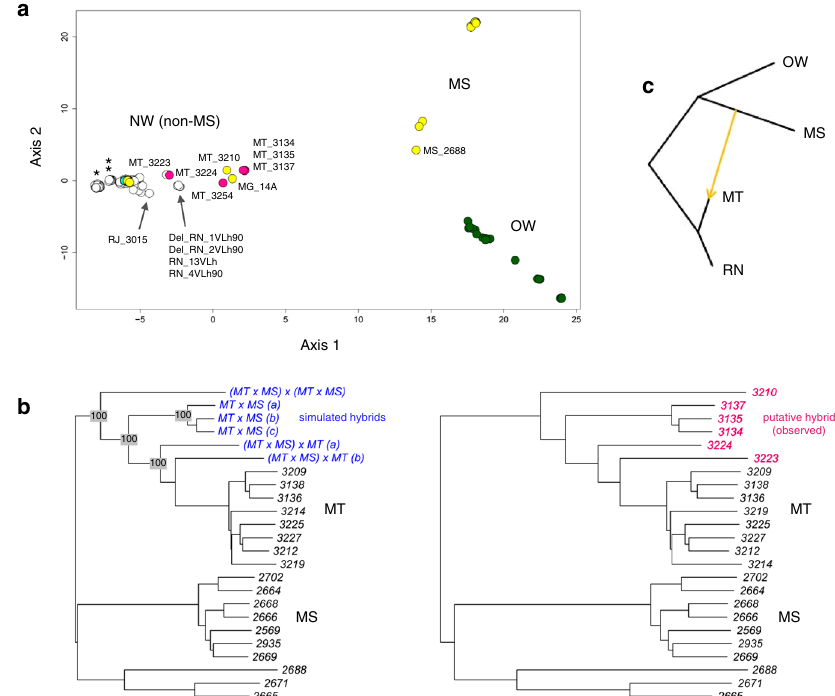
Fig. 5 Metric multidimensional scaling, simulated mating, and tree-to-graph conversion suggest admixture and hybridization between Del and NonDel L. infantum groups. a Metric multidimensional scaling separates New and Old World (NW and OW) isolates on two axes of variation (goodness-of- fi t = 0.40). NonDel isolates from Mato Grosso do Sul (MS) and Del isolates from Rio Grande do Norte (RN, see asterisk) and Mato Grosso (MT, see double- asterisk) position at opposite ends of axis 1, the primary axis of divergence within and between NW populations. HTZ isolates occur at intermediate positions (see pink circles) between these dissimilar groups. Other isolates with such intermediate positions are labeled and may also represent mating events between dissimilar groups. Gray, white, and cyan fi ll colors, respectively, indicate NonDel, Del, and MIX read-depth pro fi les found in the NW. Circles for OW (NonDel) isolates are green. Five outlier isolates are excluded as in Fig. 4. b Neighbor-joining positions of simulated hybrids (blue font, left tree) correspond to those of observed HTZ isolates (pink font, right tree) from MT. Hybrids were simulated in two steps. Random 50% haplotype contributions were fi rst drawn from Del and NonDel isolates observed in MT and MS. The resultant offspring genotypes were then either let diversify through random mutation or subjected to a second round of Mendelian recombination as before. The same tree topology resulted in each of 100 simulation replicates. Trees are midpoint-rooted as opposed to outgroup-rooted as in Fig. 4. c Given that mating can create non-treelike divergence patterns within species, TreeMix 66 was used to search iteratively for up to fi ve migration edges that improve the fi t of a maximum-likelihood tree built based on Gaussian approximation of genetic drift among isolates from MT, MS, RN, and OW groups. This input tree (black edges) suggests dichotomous differentiation into MT/RN and MS/OW clades and has a log-likelihood of 84.9206. Tree-to-graph conversion by addition of a migration edge from MS to MT increases log- likelihood to 84.9775. No other edges further increase the fi t of the input tree. A four-population test 76 also supports post-split admixture between MS and MT or RN, because differences in allele frequencies between MT and RN isolates correlate with those within the other population pair (F 4 -statistic = 5 × 10 − 5 , Z -score = 3.51).